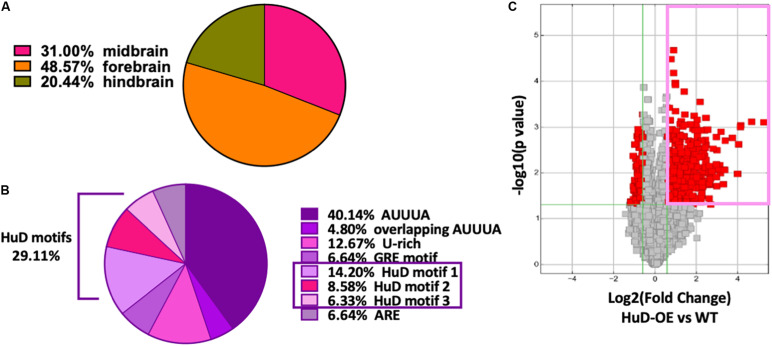
High frequency of HuD binding motifs in mouse brain circRNAs. (A) 38.7% of mmu_circRNAs are expressed in the brain; of these, 31% in the midbrain, 48.57% in the forebrain and 20.44% in the hindbrain. (B) Bioinformatics analysis of mouse circRNAs showing distribution of ARE sequences. Completely annotated mmu_circRNA sequences from circBase were analyzed and 33 % were found to have HuD consensus binding motifs and other ARE motifs. Pie chart from this set of circRNAs shows the percentage of each ARE motif including 29.11% of HuD specific motifs (14.20% motif 1; 8.58% motif 2, 6.33% motif 3). (C) Volcano plots representing the differential enrichment of circRNAs in the HuD RIP vs. WT controls (pink rectangle). The RNA obtained after HuD immunoprecipitation was subjected to circRNA array analysis as described in section “Materials and Methods.” The vertical lines correspond to 1.5-fold change up and down, respectively, and the horizontal line represents a p-value of 0.05, n = 3 for each IP (HuD-OE, WT and IgG); three mice were pulled together for each IP and the tissue analyzed in three separate RIP assays. Data points in red represent differentially expressed circRNAs.